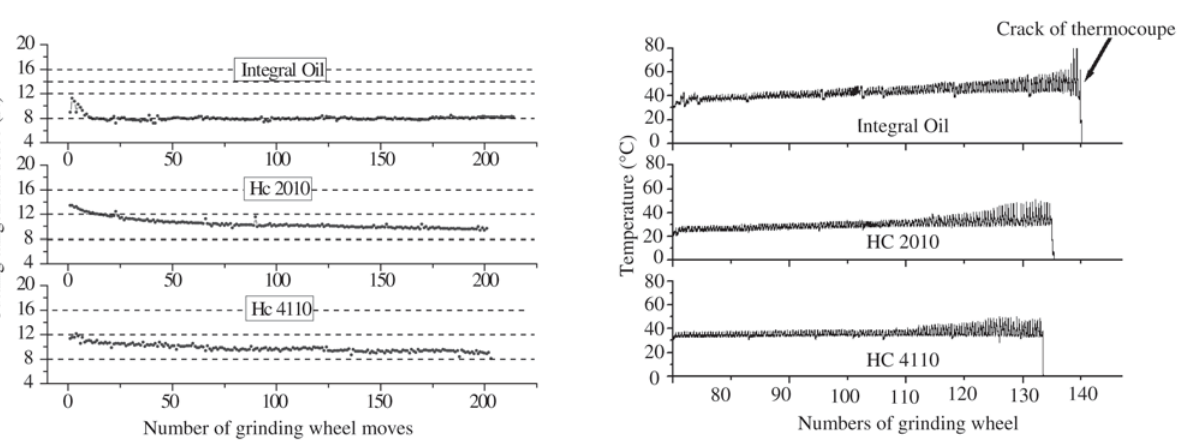
Figure 6. Tangential force comparative results.